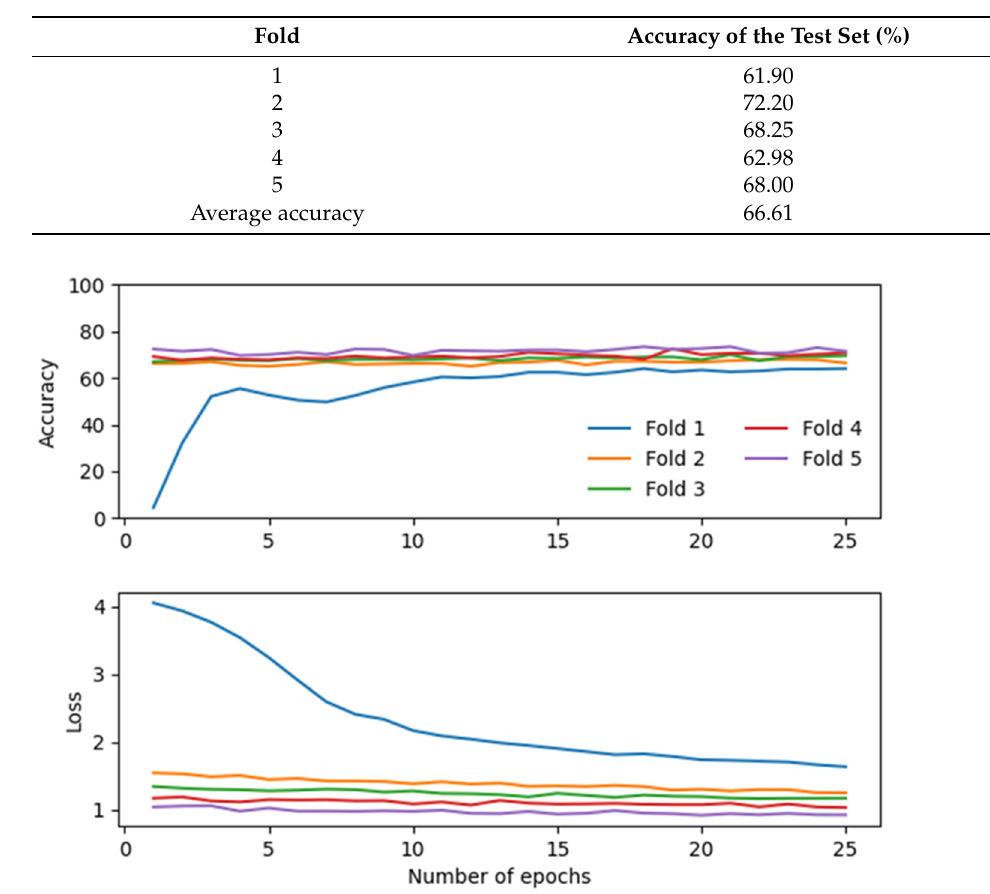
Table 3. Accuracy of the model including one hidden layer and 60 nodes tested with the available test set.